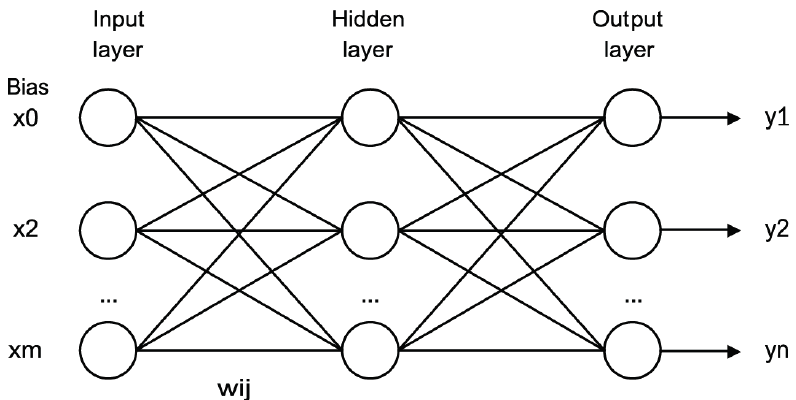
Figure 1. Neural network